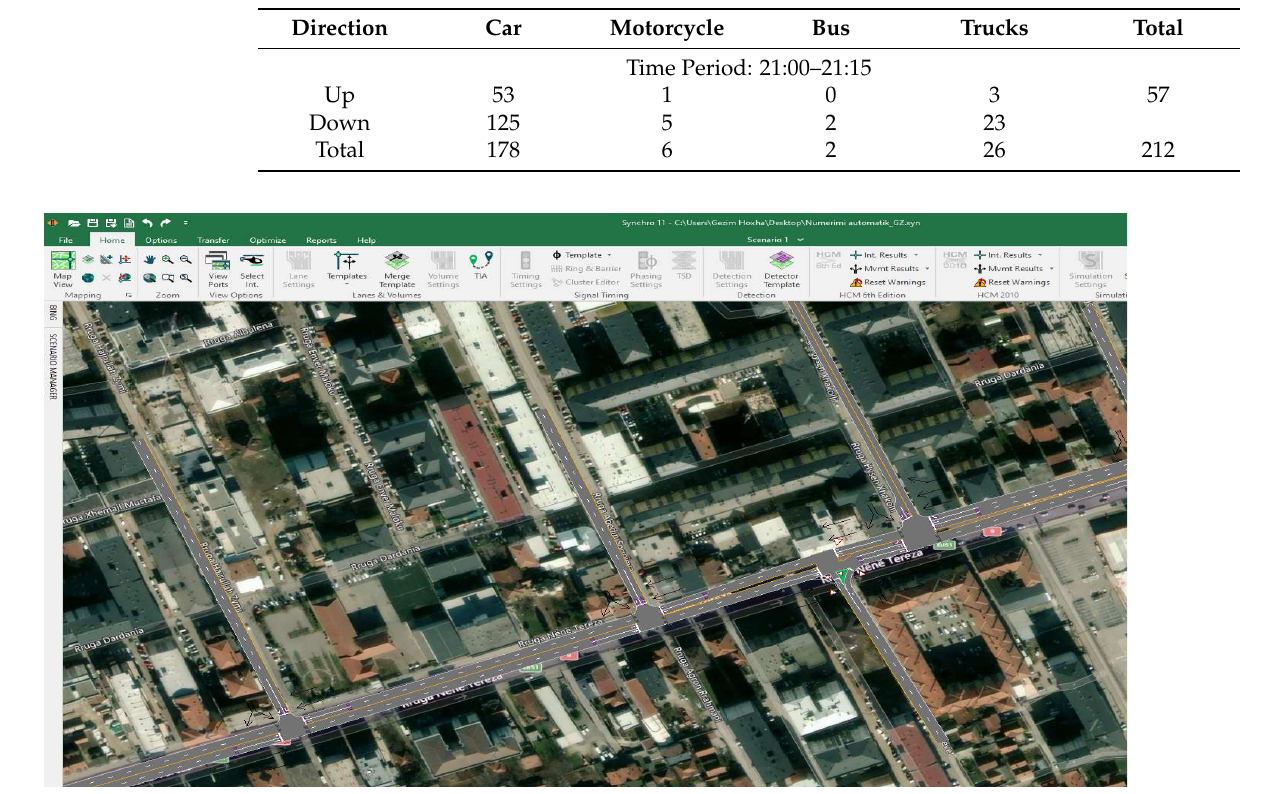
Table 3. Results obtained from camera count in the evening.